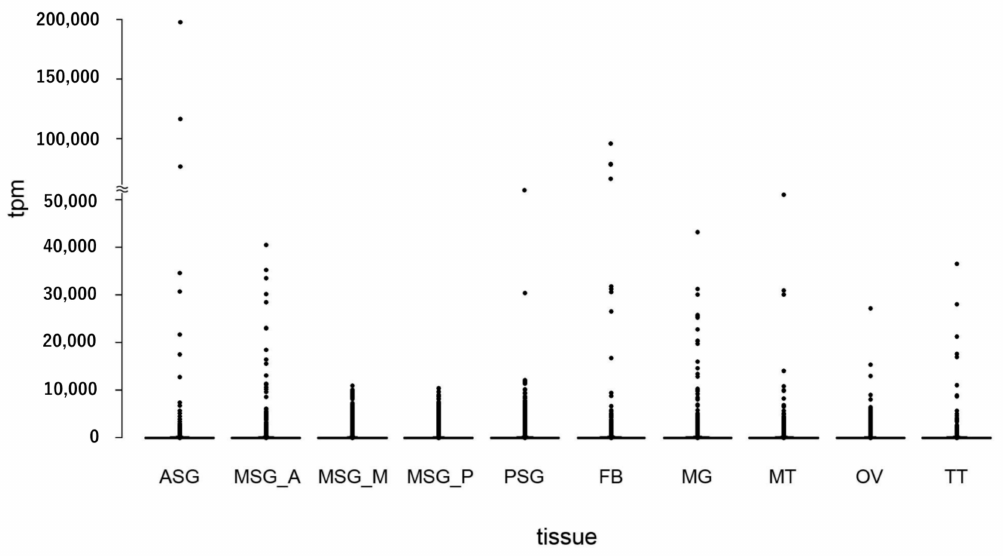
Figure 7. A scatter plot of the transcript expression in each tissue. Each spot shows the tpm value.